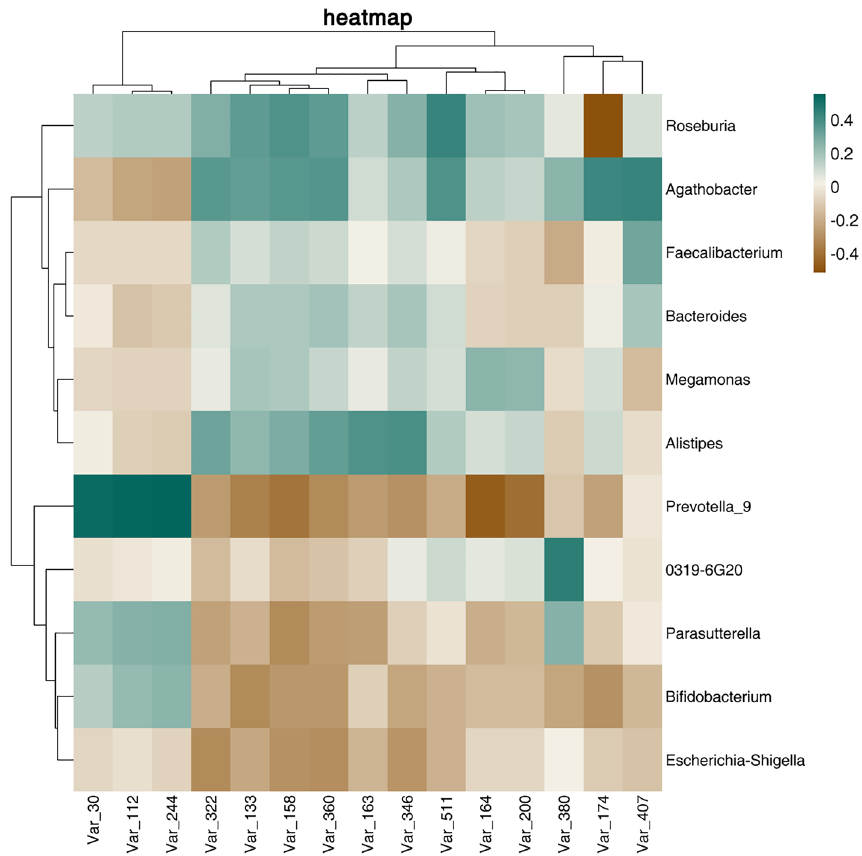
Figure 4. Heat map of Pearson correlation analysis between gut microbiota and serum metabolites in PCOS